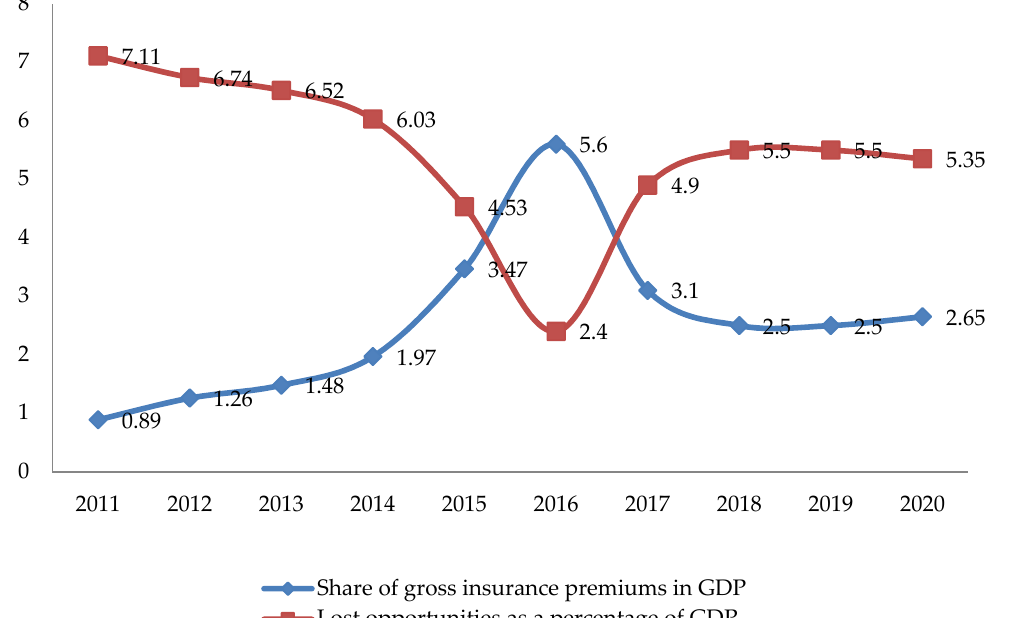
Figure 1. Indicators, characterizing the development level of the insurance market and the lost opportunities by insurance companies of the Russian Federation in 2011–2020 in the context of digitalization. Source: Compiled by the authors based on https://cbr.ru/analytics/insurance/ overview_insurers/ (accessed on 2 October